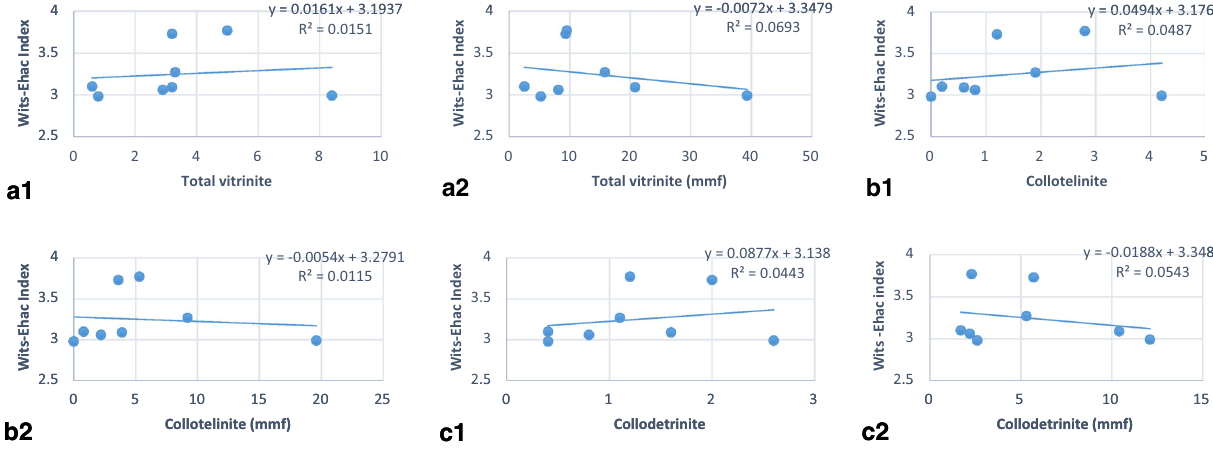
Fig. 8 Influence of total vitrinite and its group on spontaneous combustion liability of